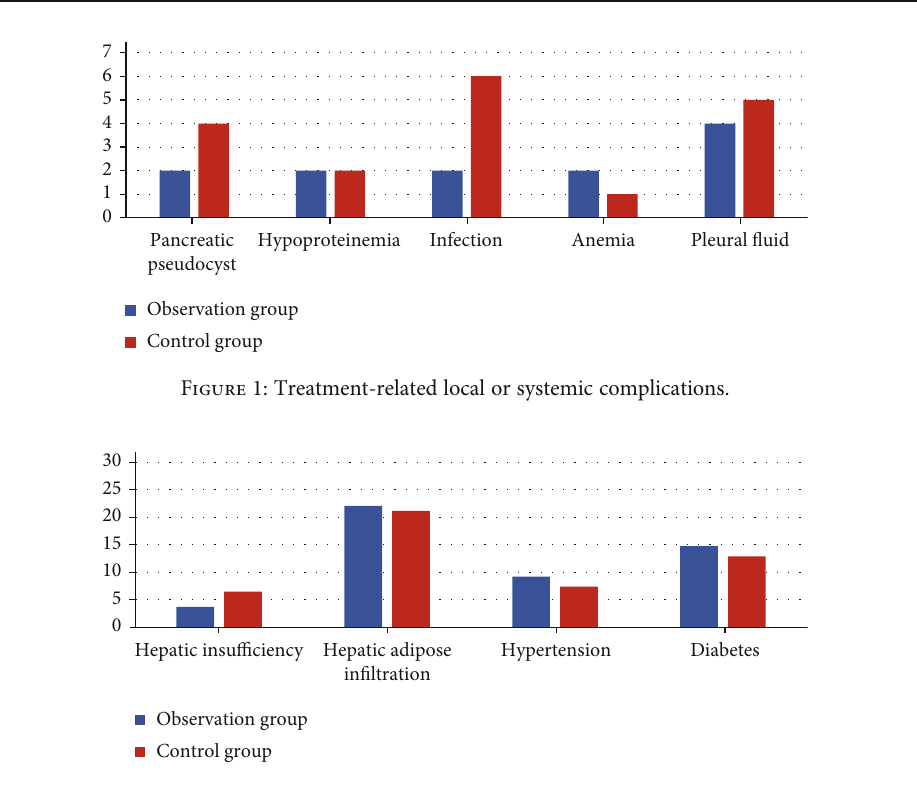
Figure 2: The basic metabolic diseases of the two groups of patients. Table 4: Pearson analysis between amylase, high-low-density Table 5: Pearson analysis between lipase, high-low-density lipoprotein, and TG in HTGP patients. lipoprotein, and TG in HTGP